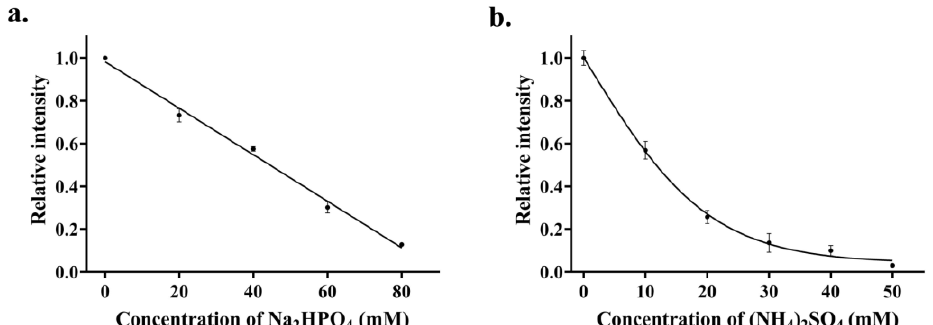
Figure 5. ( a ) Inhibition effects of Na 2 HPO 4 on phosphorylation. ( b ) Inhibition effects of (NH 4 ) 2 SO 4 on phosphorylation. The fluorescence intensities at 650 nm were all normalized to 1. The error bars represent the standard deviation (SD) across three repetitive experiments over the blank response.